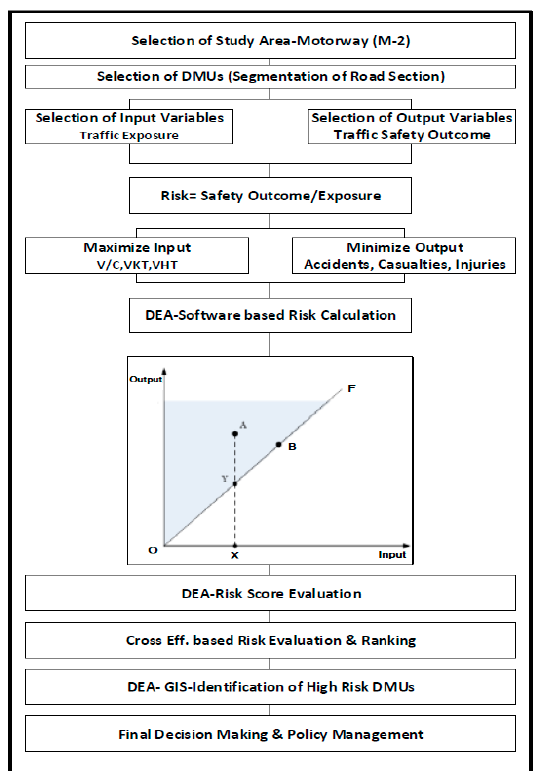
Figure 4. Methodological framework. DMUs: decision-making units; GIS: geographical information system; V / C: volume / capacity; VKT: vehicle kilometers travelled; VHT: vehicle hours traveled.